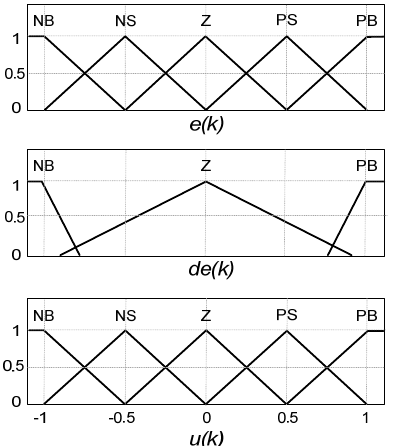
Figure 6. Membership functions for the voltage control loop.